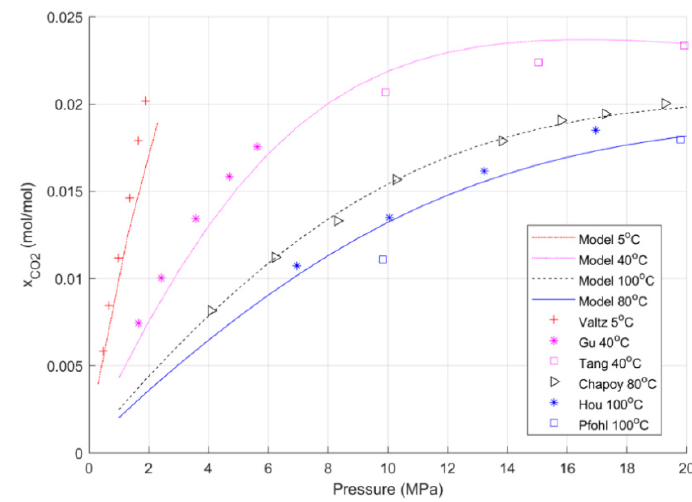
Figure 8. Validation of pure H 2 S solubility with new experimental data. (No intersection with Diamond et al. research.)